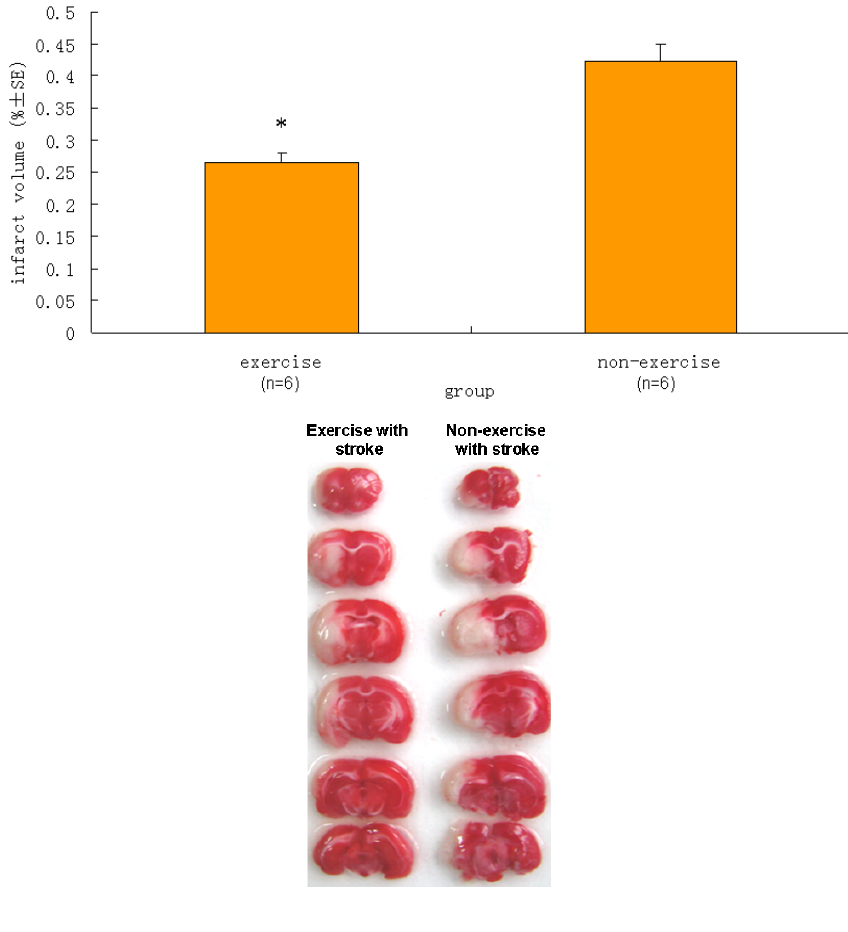
Figure 4. Difference in infarct volume between the exercise group and the non-exercise group. Top panel: Data are mean ± S.E. (n = 6). The infarct volume of the sham group of six rats was zero (not shown). * denotes a statistically signi fi cant difference in the mean infarct volumes of the exercise group and the non-exercise group (P < 0.05). Bottom panel: 2 mm coronal sections show ischemia (pale regions) and healthy tissue